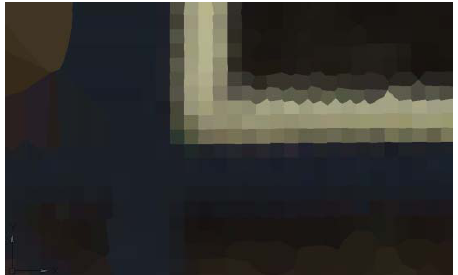
Figure 6. Voronoi diagram polygons calculated for the points that belong to the window’s plan, with the corresponding RGB